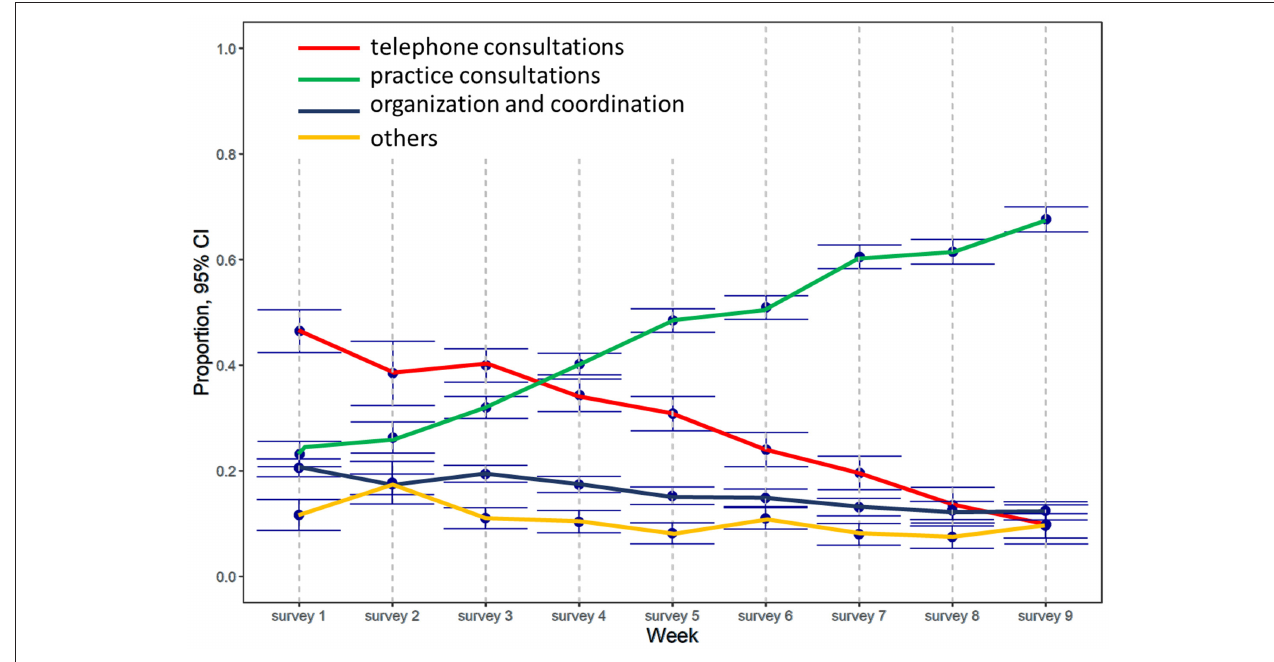
FIGURE 1 | Presentation of received